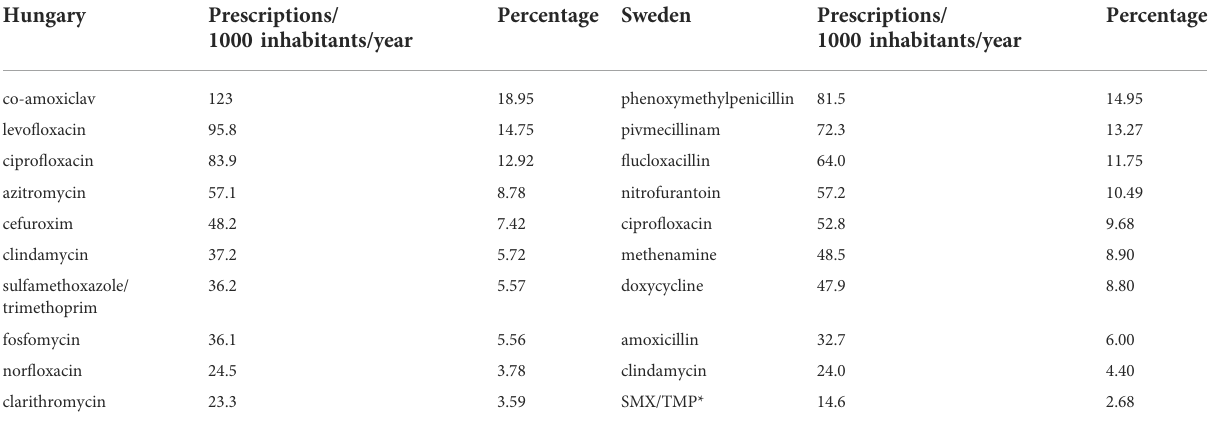
TABLE 2 The top ten list of antibacterials used in the elderly population in Hungary and Sweden